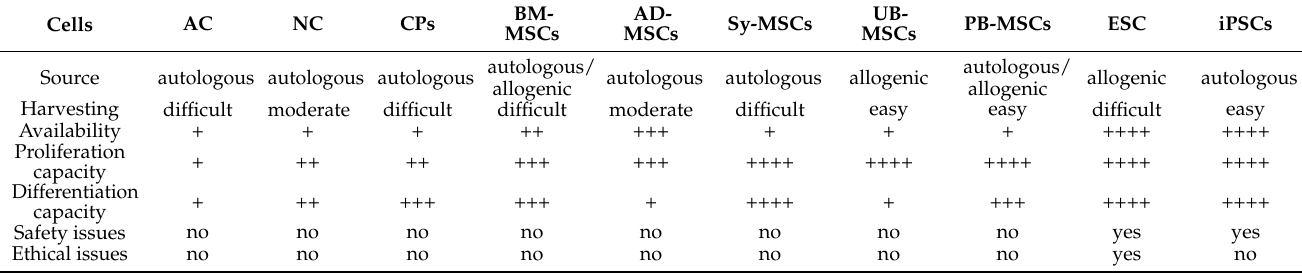
Table 1. Comparison of cell properties relevant to their application for cartilage treatment (number of pluses represent the scale where + means low, ++ moderate, +++ high, and ++++ very high).